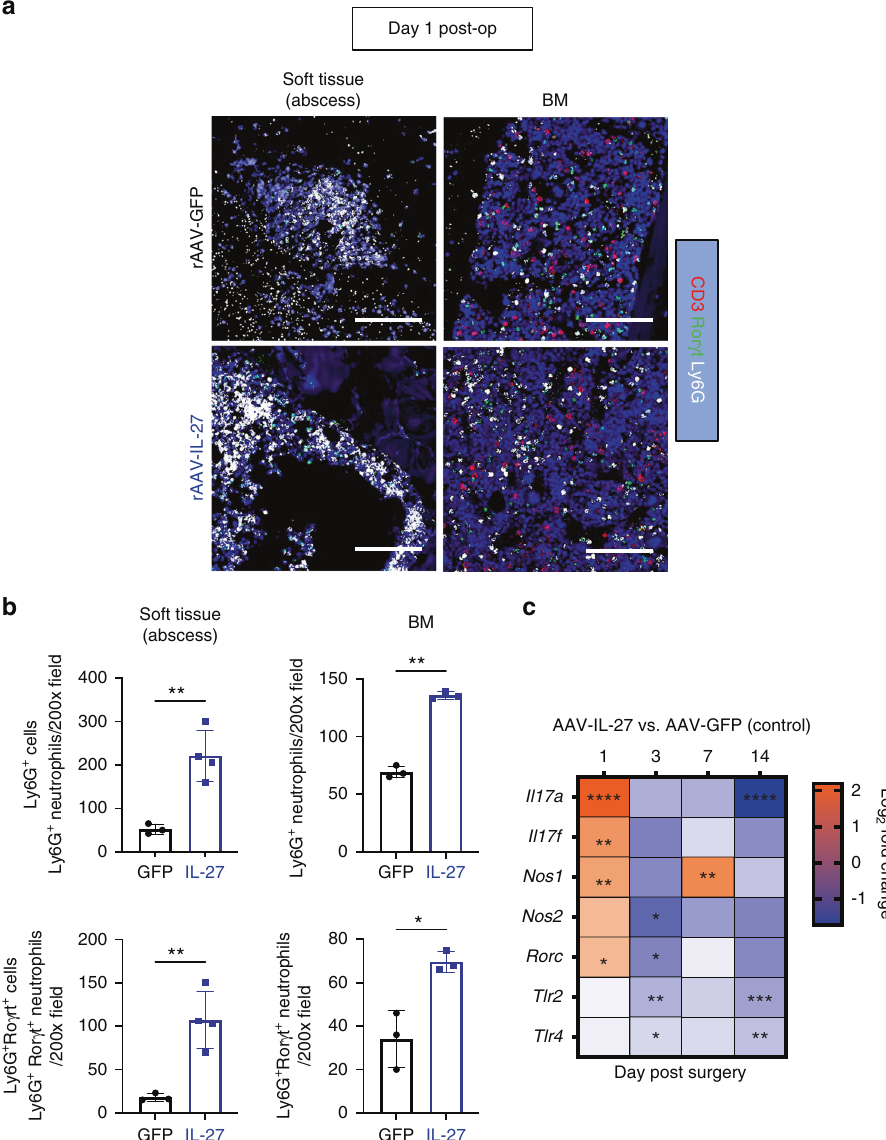
Fig. 4 Systemic IL-27p28 enhances the accumulation of ROR γ t + neutrophils at the site of infection in mice with implant-associated S. aureus osteomyelitis. a Tibiae from WT mice infected with rAAV-GFP or rAAV-IL-27p28 and challenged with a MRSA-contaminated implant as described in Fig. 3 were harvested on Day 1 post-surgery and processed for multiplex immuno fl uorescence microscopy. Representative images of tibial sections containing abscesses adjacent to the pin and noninvolved bone marrow (BM) on Day 1 post-surgery stained for Ly6G + (white), ROR γ t (green), and CD3 + (red) are shown at 200× magni fi cation (scale bar = 100 µm). b Histomorphometric analysis was performed to quantify the numbers of Ly6G + and Ly6G + ROR γ t + neutrophils per 200× fi eld in soft tissue and BM, and the data are presented with the mean ± SD for the group ( n = 3 or 4, * P < 0.05, ** P < 0.01, t -test). c Gene expression pro fi les associated with neutrophil migration are shown on a heatmap with log 2 fold change values on each day in mice treated with rAAV-IL-27p28 vs. rAAV-GFP. Orange and blue indicate upregulation and downregulation, respectively ( n = 3, log 2 fold change, * P < 0.05, ** P < 0.01, *** P < 0.001, **** P < 0.000 communities (SACs) and reduced bone loss at the surgical site. Immunohistopathology of infected tibiae revealed an increased number of neutrophils (Ly6G + cells) on Day 1 post-surgery in both SACs and the adjacent bone marrow in rAAV-IL-27p28- treated animals compared to rAAV-GFP control animals (Fig. 4a). Histomorphometric quanti fi cation con fi rmed the signi fi cant increase in neutrophils in SACs and in the bone marrow in the rAAV-IL-27 group (Fig. 4b, P < 0.05). Interestingly, increased numbers of Ly6G + ROR γ t + neutrophils were observed in the rAAV-IL-27p28 group (Fig. 4a, b, P < 0.05), suggesting a possible involvement of proin fl ammatory IL-17 signaling in bacterial